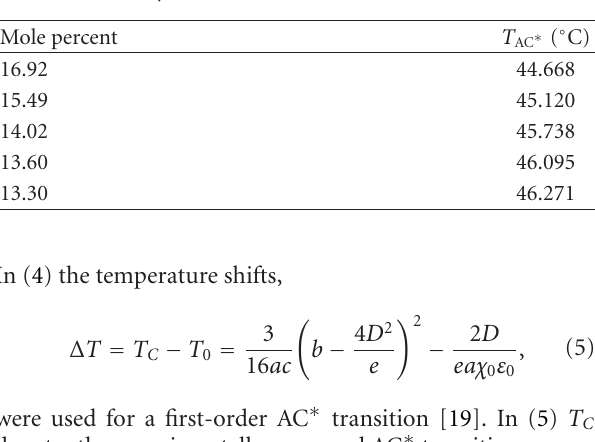
Table 1: Transition temperature ( T AC ∗ ) for the di ff erent mixtures of C7+7OPDOB system [9].